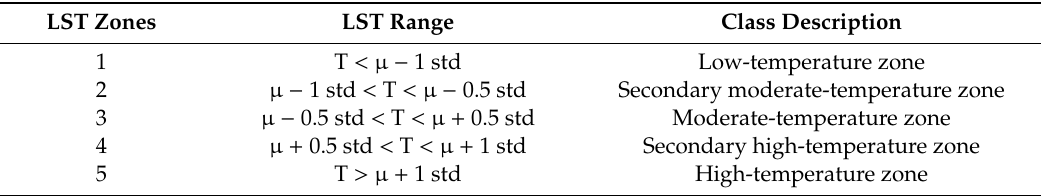
Table 2. Classification criteria of surface temperature.